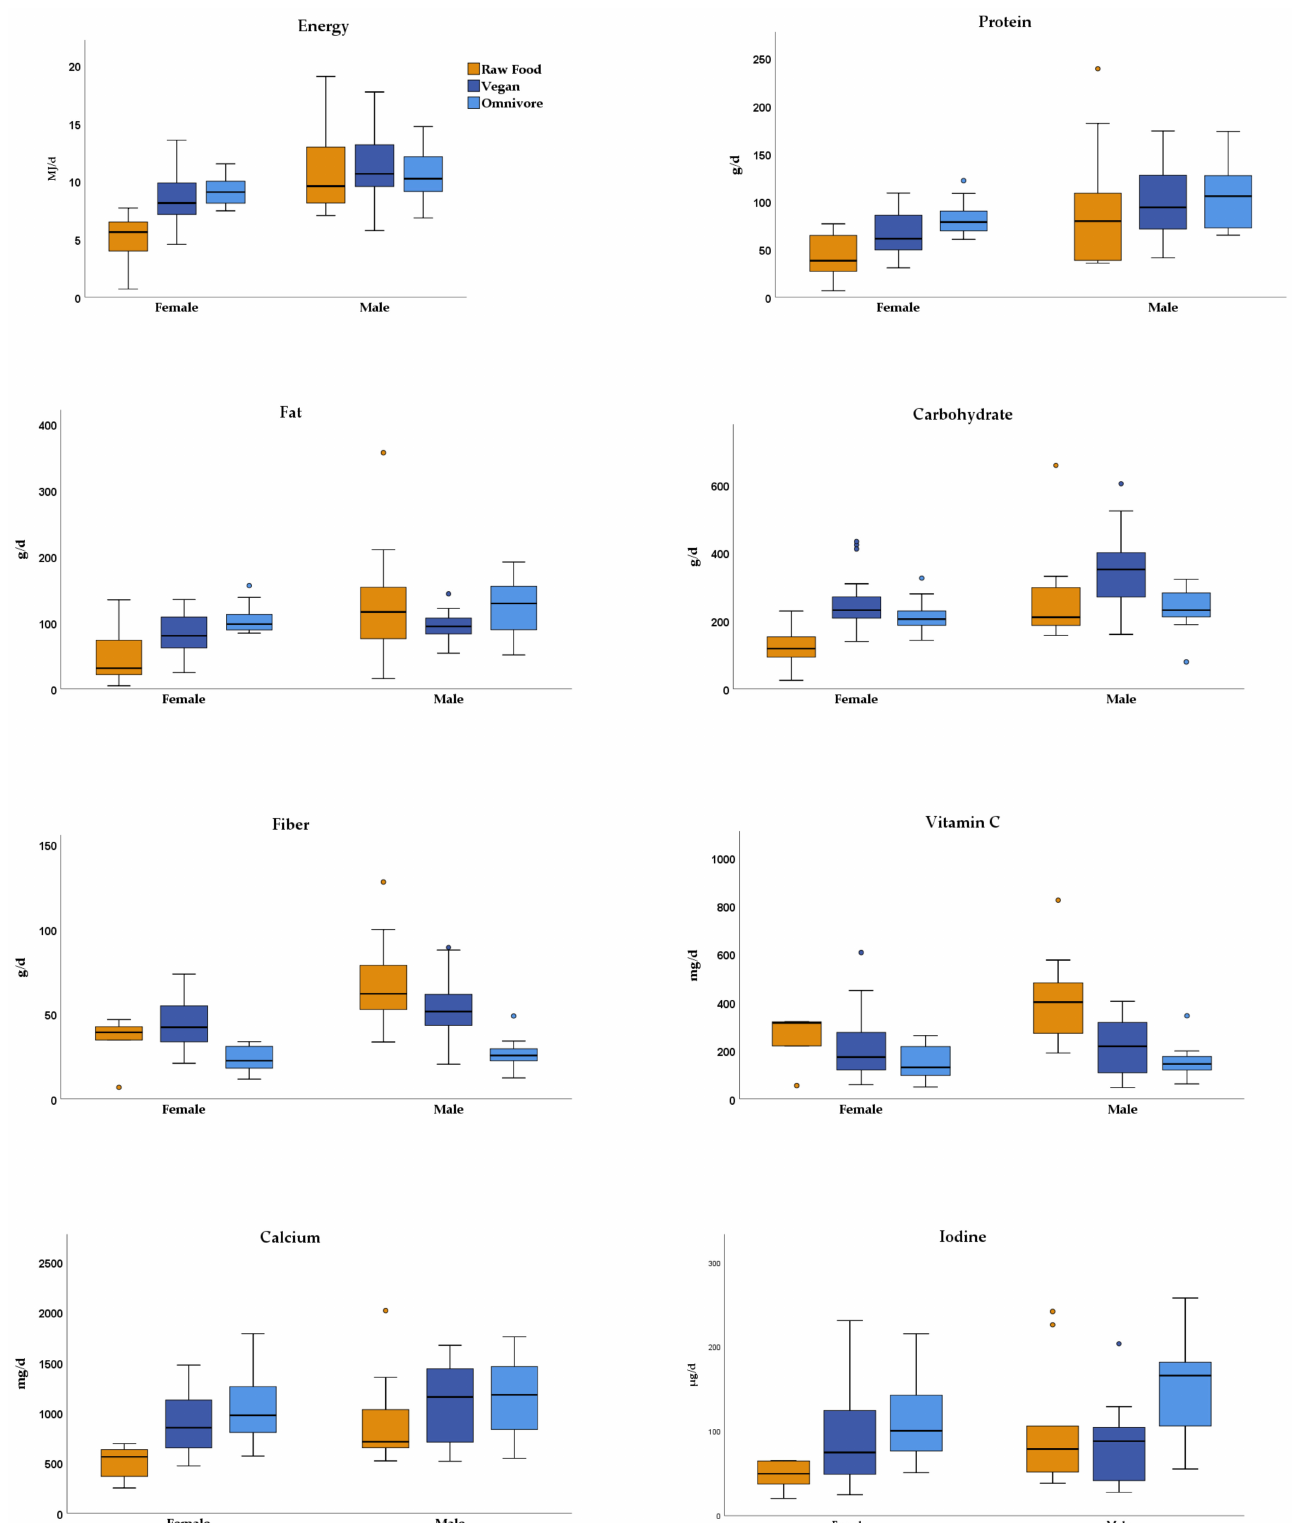
Figure 1. Intake of energy and selected nutrients in women and men of raw food eaters, RBVD vegans and RBVD omnivores. Median of energy (MJ/day), macronutrients (g/day) and micronutrients (mg/day or µ g/day) are based on 3-day weighed food records. Coloured dots are